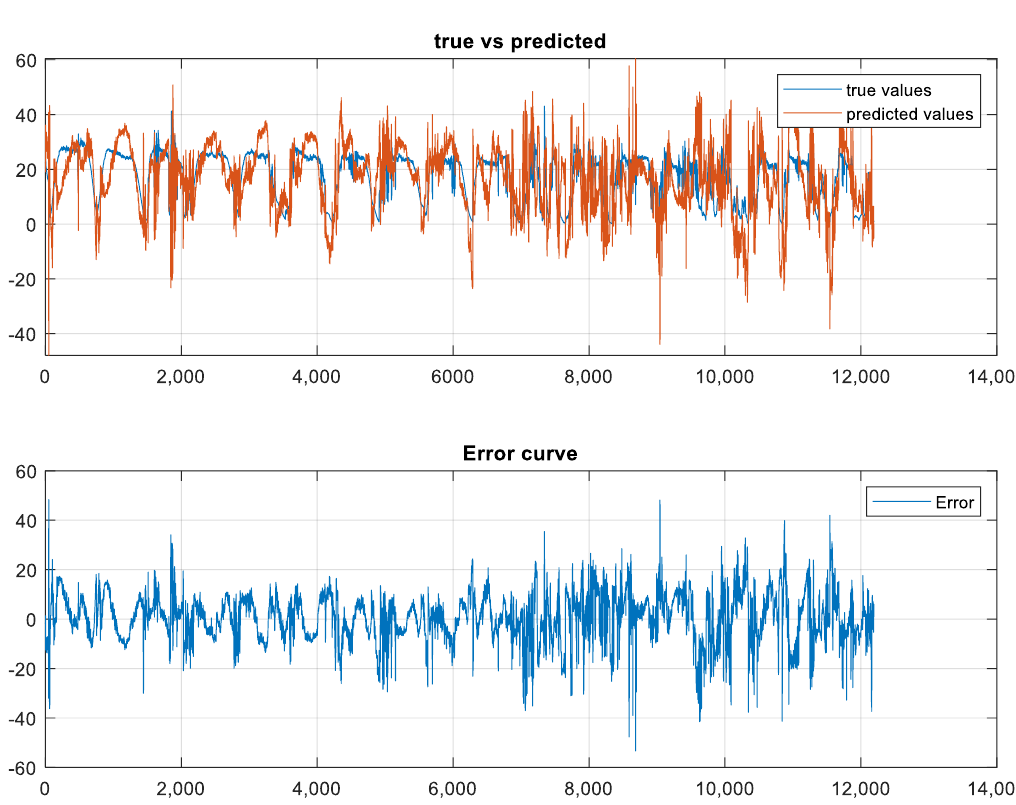
Figure 7. Error and output of GA–ANN results (second test). 3.4. ANN with PSO Validation of the PSO – ANN is shown in Figure 8.